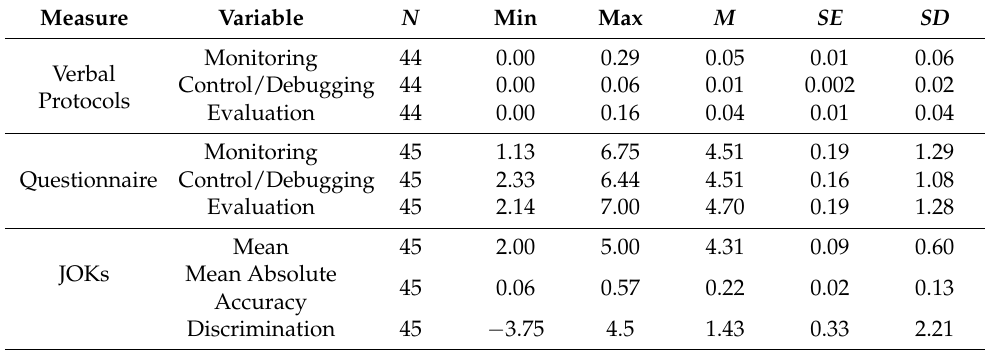
Table 4. Descriptive statistics for each measure.